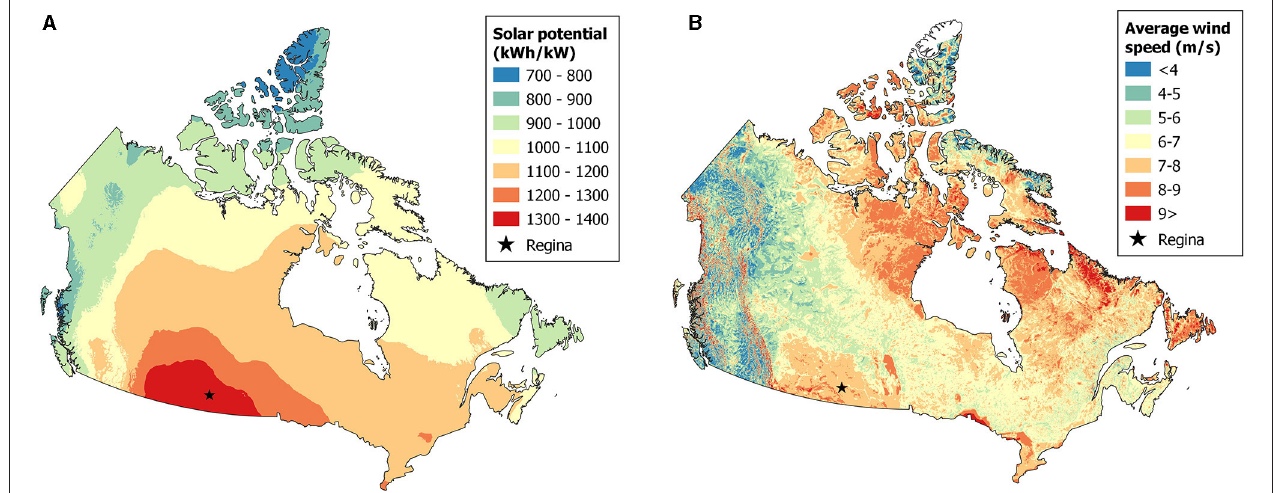
FIGURE 1 | (A) Solar potential map (Government of Canada et al., 2020) (left) and (B) wind potential map (Global Wind Atlas, 2019)